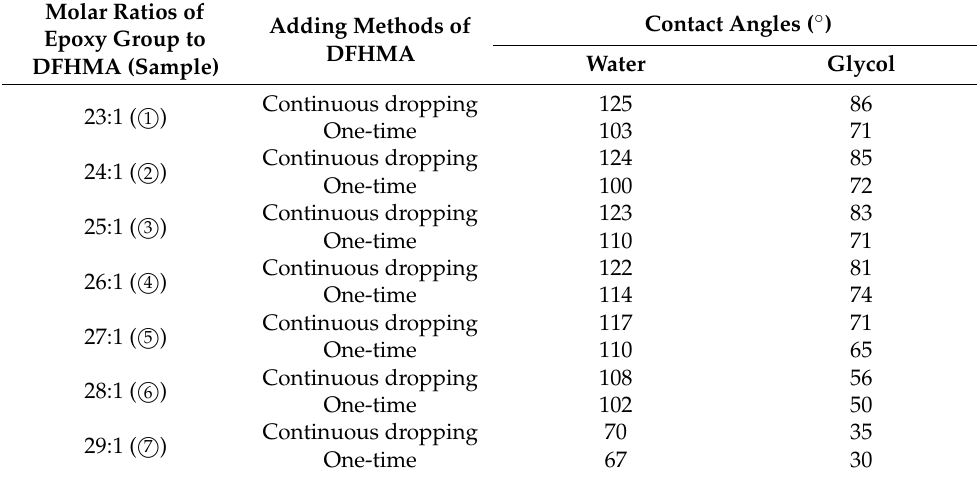
Table 1. Effect of adding methods of fluorine-containing monomers on contact angle of coating